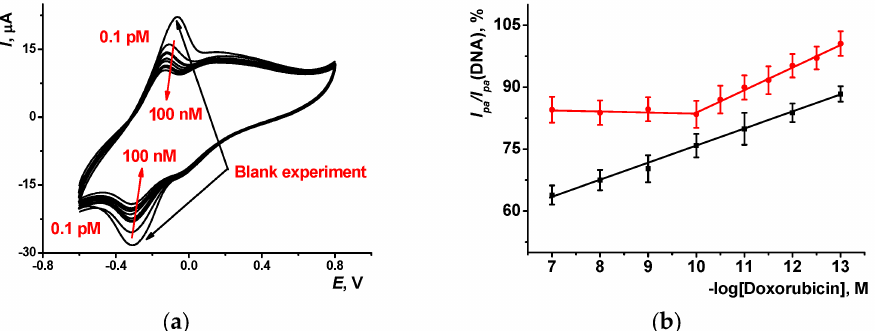
Figure 6. ( a ) Cyclic voltammograms recorded on the GCE covered with the (PAA+CB)/DNA+MB layer prior to and after 20 min incubation in 0.1 pM, 1 pM, 10 pM, 0.1 nM, 1 nM, 10 nM, 100 nM doxorubicin solution; arrows show the direction of the changes observed with increasing dox- orubicin concentration; ( b ) Calibration curves of doxorubicin obtained with GCE covered with (PAA+CB)/DNA+MB (black) and (PAA+fMWCNTs)/DNA+MB (red)-based biosensors. Relative changes of the oxidation peak currents are used as the signal, measurements in 0.1 M phosphate buffer with 0.1 M NaNO 3 , pH 7.0, scan rate 100 mV/s. Average ± S.D. values were calculated for six individual DNA-sensors. Table 1. Analytical characteristics of doxorubicin determination based on relative changes in the poly(Azure A) ( I p / I p (DNA) peak currents recorded after DNA deposition, MB treatment and in- cubation of the DNA-sensor in doxorubicin solution. I p / I p (DNA),% = a − b log([Doxorubicin], M), Average ± S.D. values were calculated for six individual DNA-sensors. Coating Peak Current Conc.